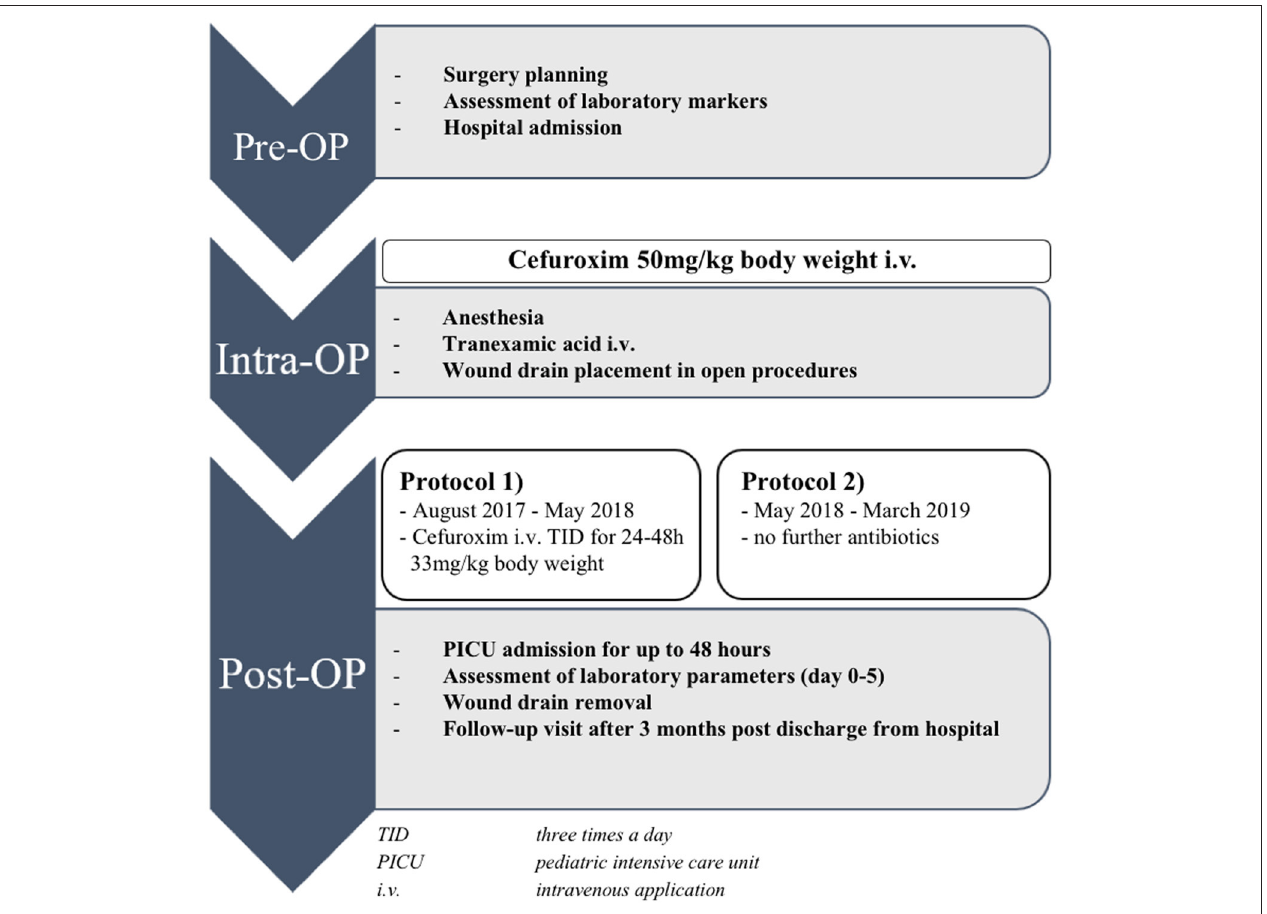
FIGURE 1 | Perioperative procedure of children undergoing elective craniosynostosis correction. TID, three times a day; ICU, intensive care unit; i.v., intravenous